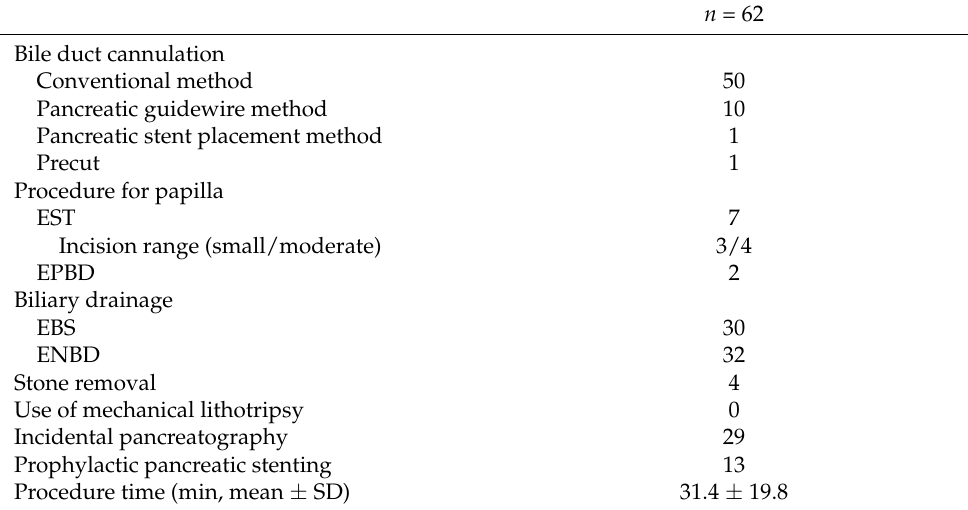
Table 3. Endoscopic